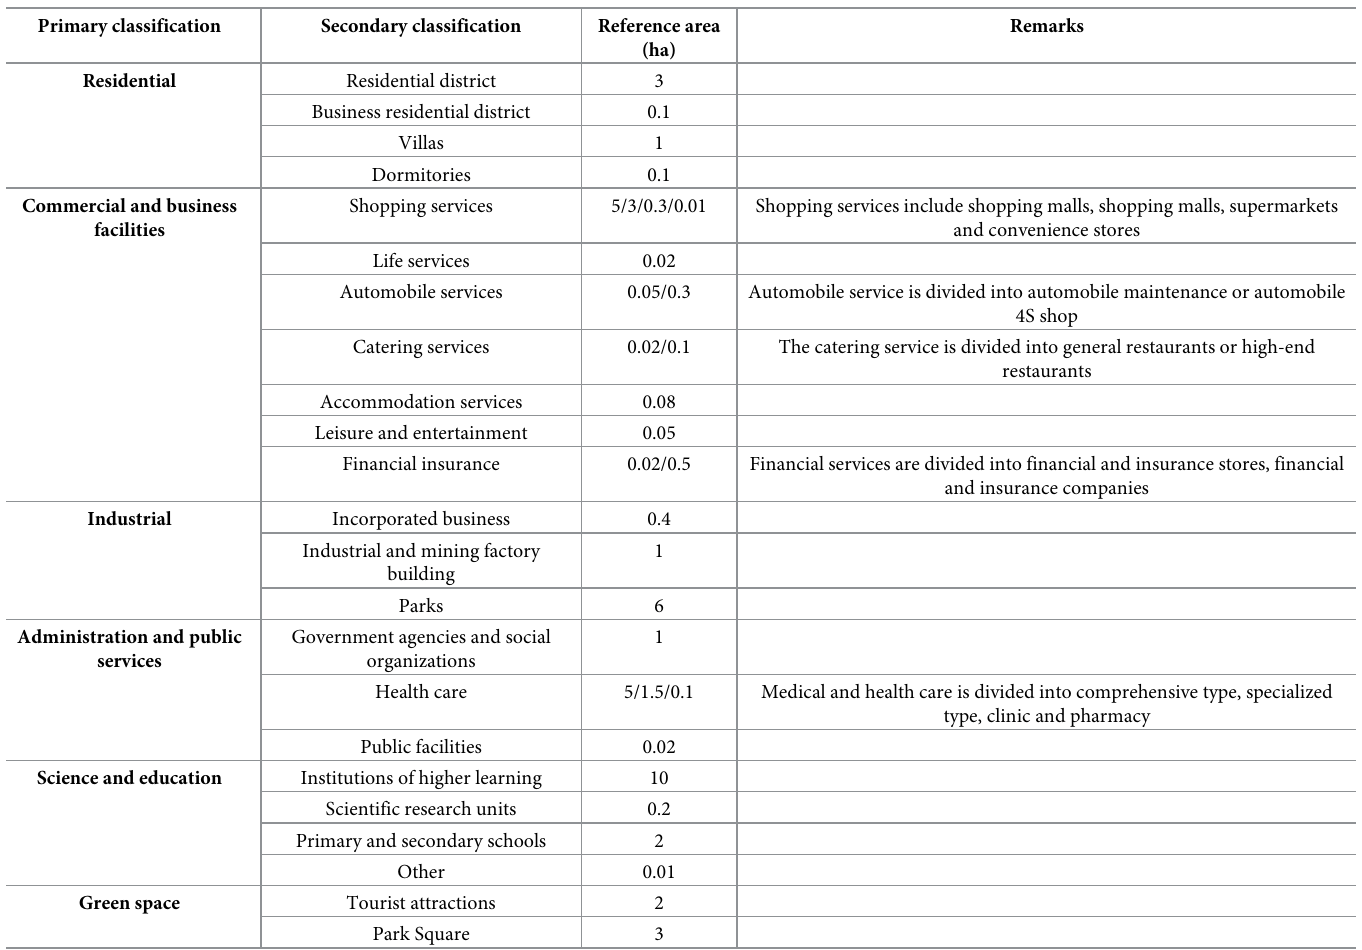
Table 2. Functional classification of POI and reference value of coverage area.